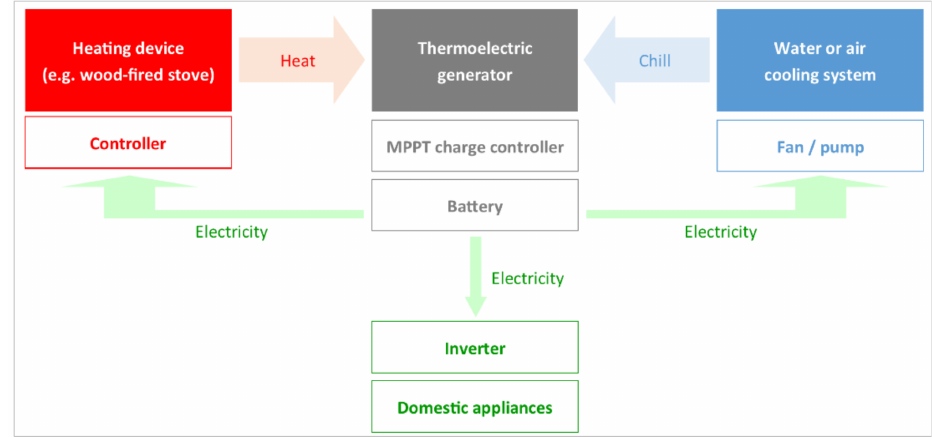
Figure 2. The idea of a power generation system with a wood stove and a thermoelectric